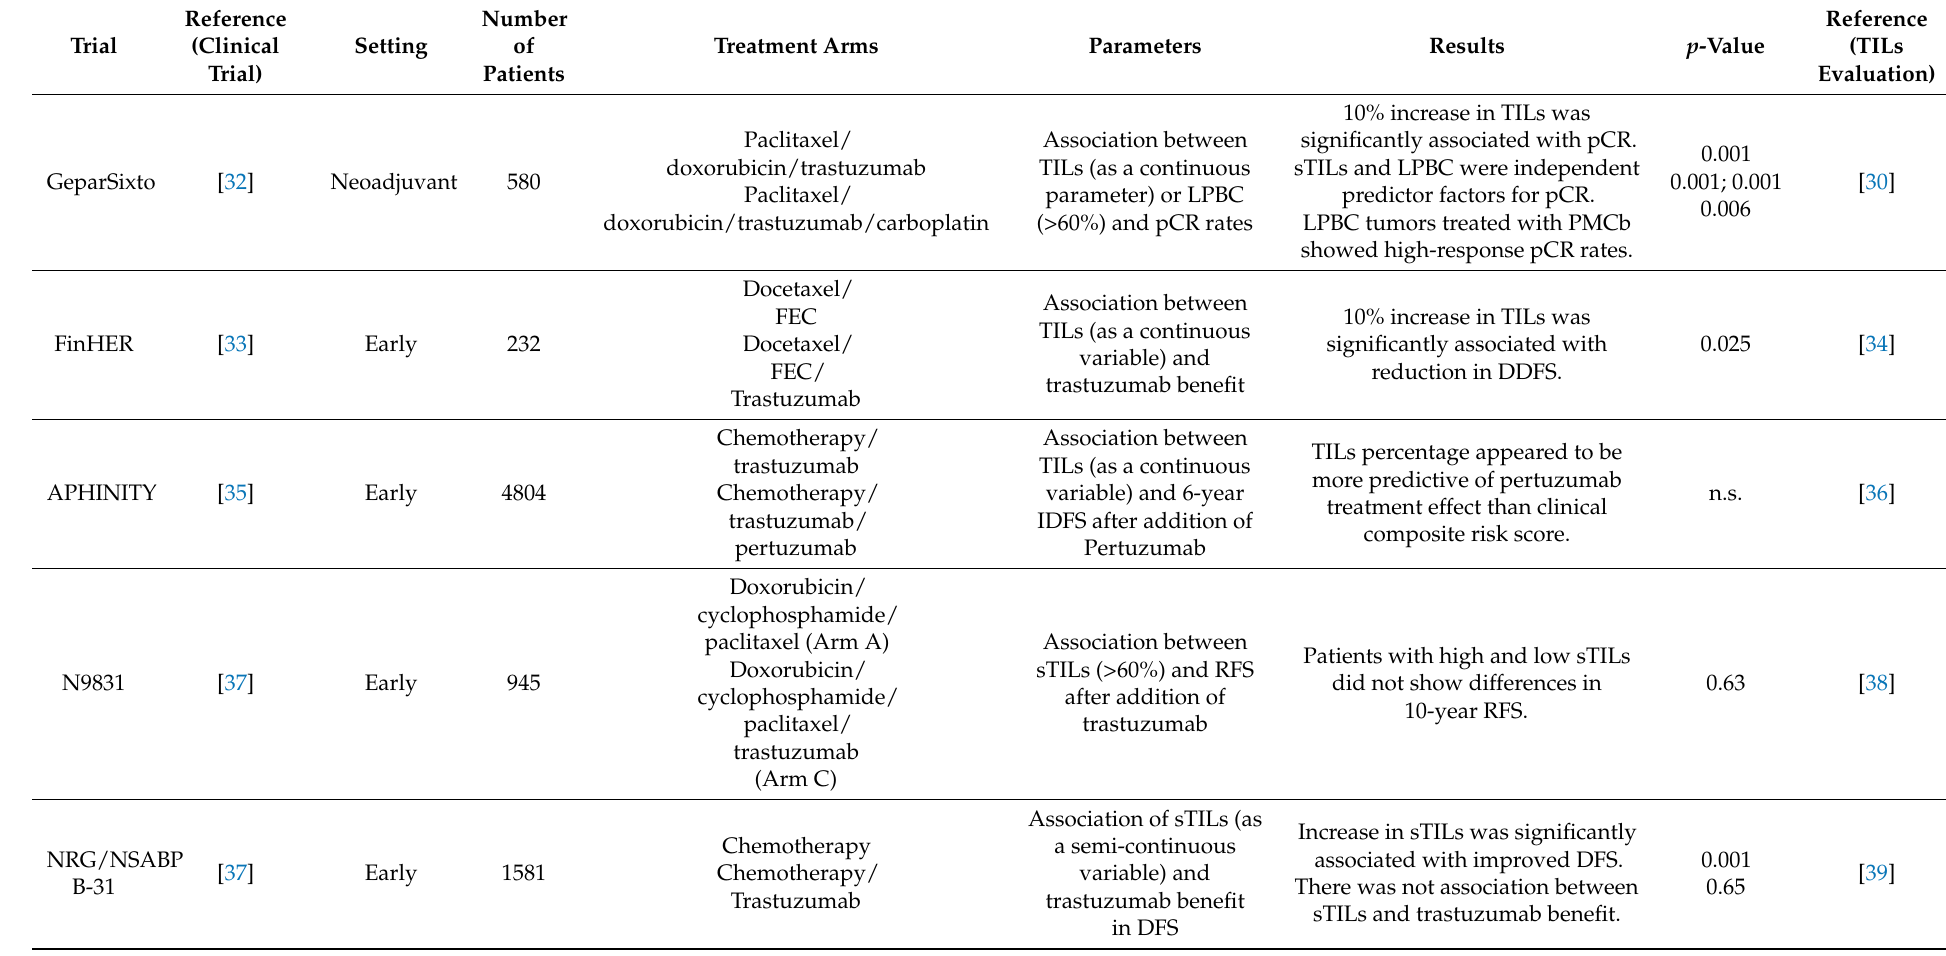
Table 1. Summary of main clinical trials with TIL evaluation in HER2-positive breast